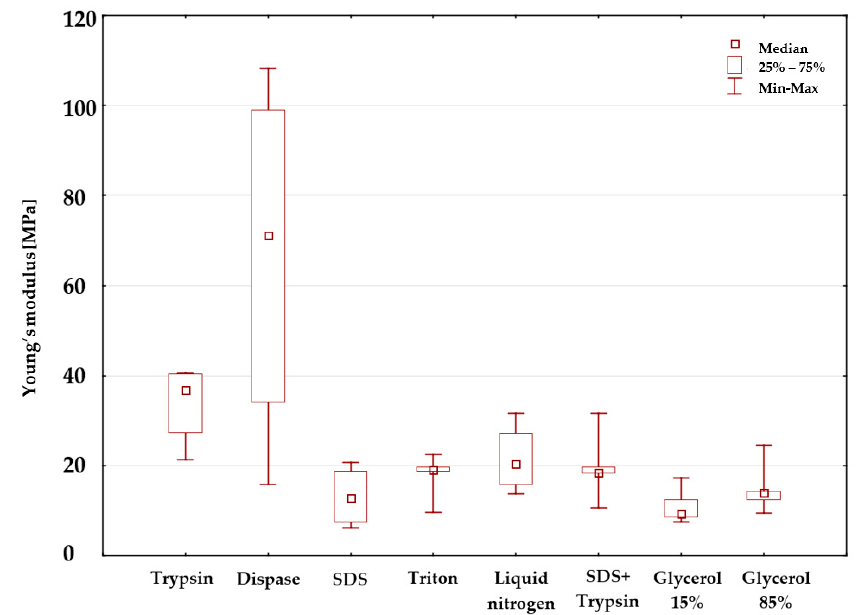
Figure 9. Diagram presenting the mean value and the standard deviations of Young’s modulus in relation to human samples before sterilization performed using various substances.